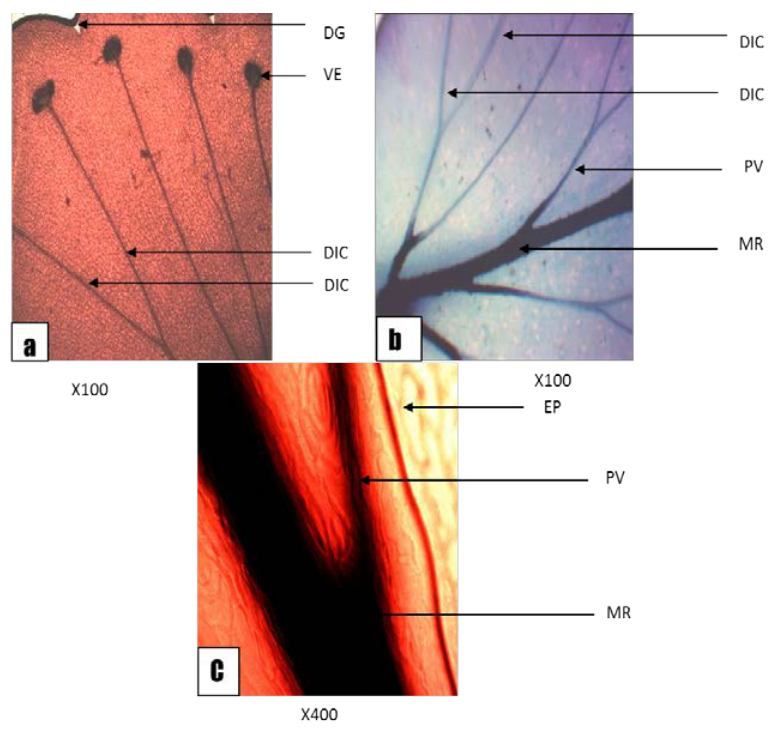
Fig. 1. Venation pattern of the leaflet of N . cordifolia DIC- dichotomously branched vein; MR- mid-rib; PV- primary vein; SV- secondary vein;TR- trichome; VE- vein ending in hydathode/sori;VI- vein; VT- veinlet; EP- epidermal cell; DG- deep groove at the margin;ST-